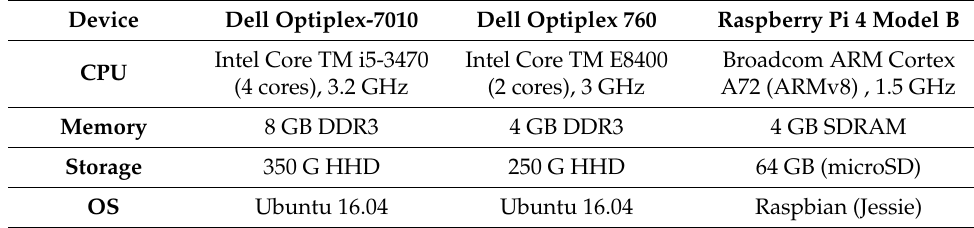
Table 2. Configuration of experimental